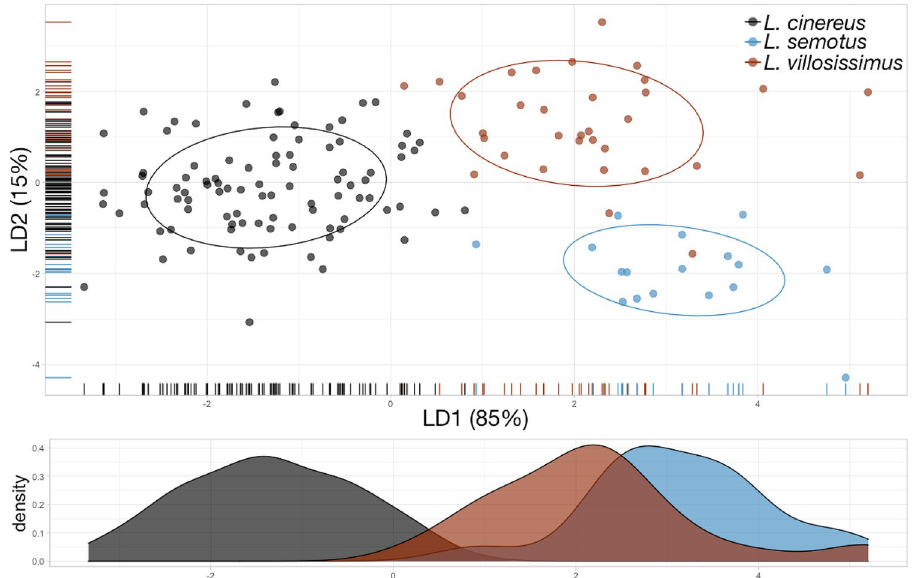
Figure 2. Results from the machine learning Linear Discriminant Analysis (LDA) classifier of phenotypic limits in hoary bats (genus Lasiurus ). Overall accuracy of the model = 97.2% (95% CI 92.9, 99.2%). Percent group separation described for the first linear discriminant (LD1) was 85 and 15 for the second linear discriminant (LD2). Solid lines represent 68% data ellipses centered at the bivariate mean to visualize phenotypic differences among species. LD1 density values plotted for aid in visualization on the x-axis highlighting closer phenotypic affinities of L. semotus and L. villosissimus , contrasting with the phylogenetic